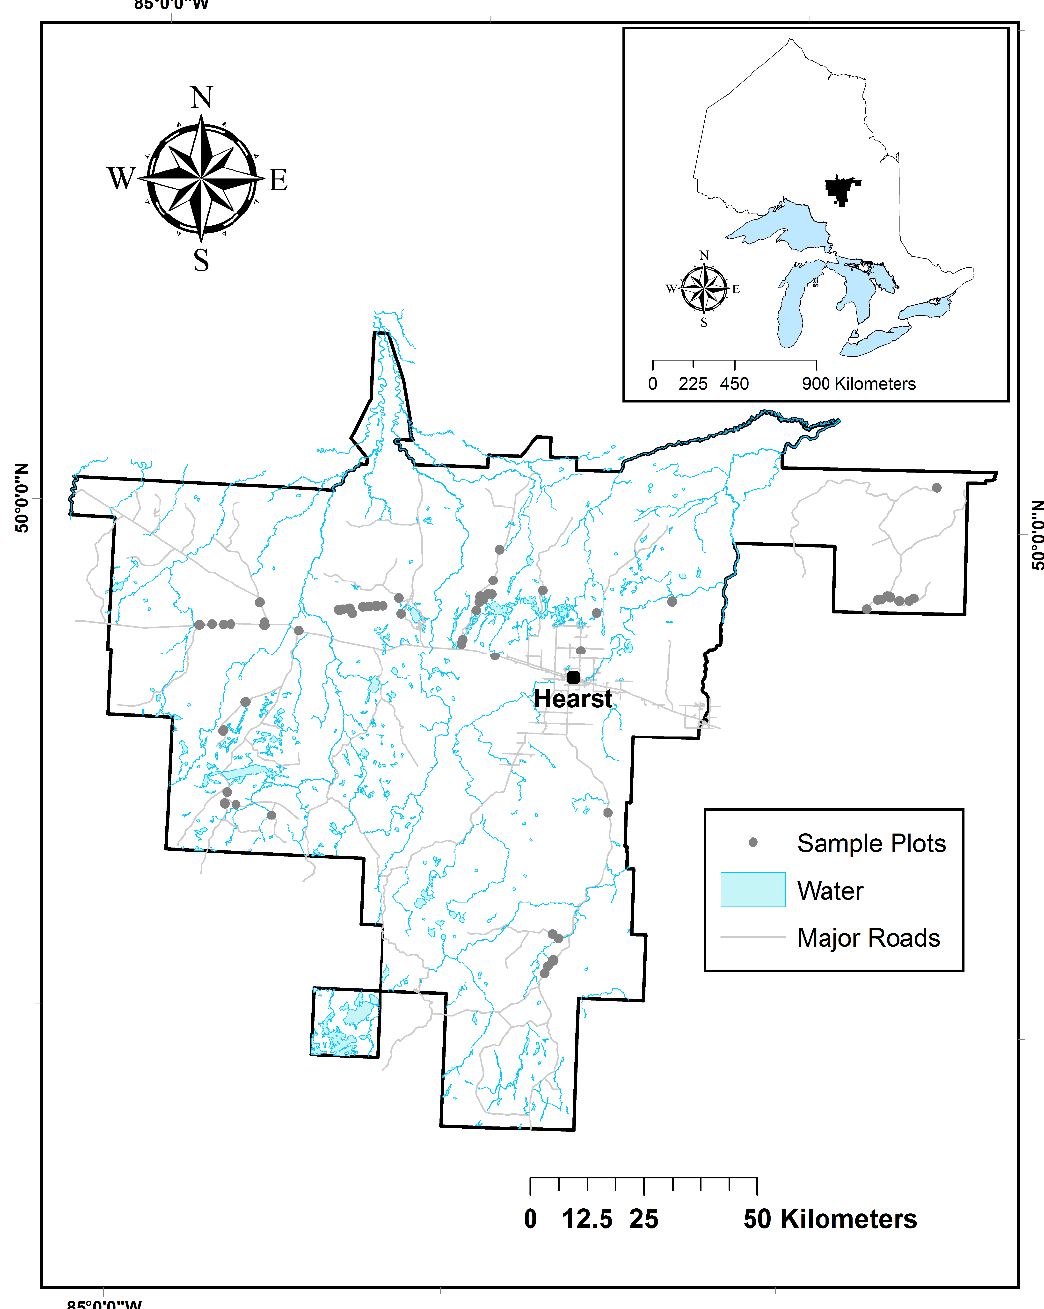
Figure 1. Sample plot location within the Hearst Forest in Ontario, Canada.